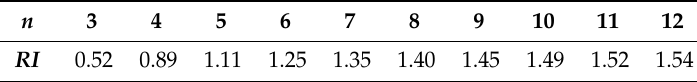
Table 2. RI values corresponding to matrix